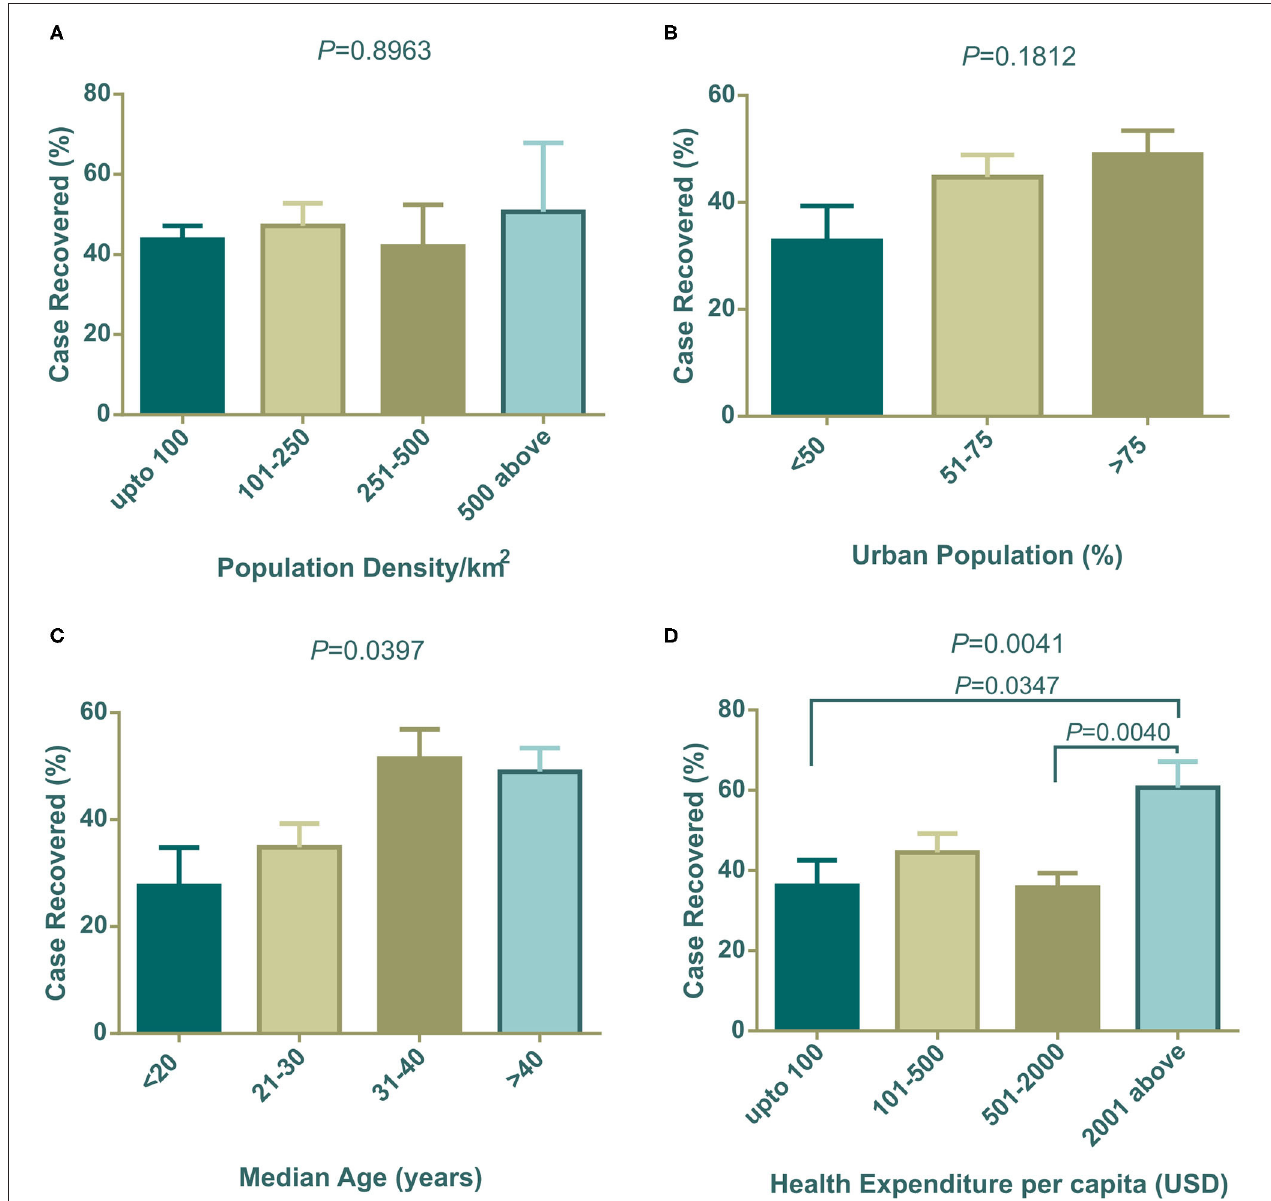
FIGURE 2 | Case recovery (%) distribution among countries categorized with population density (A) , urban population (B) , median age (C) , and health expenditure per capita (D) . One way ANOVA statistical differences among column means are shown as P- values on top of each graph. In (C,D) , differences among means are statistically significant. Data presented are mean ±